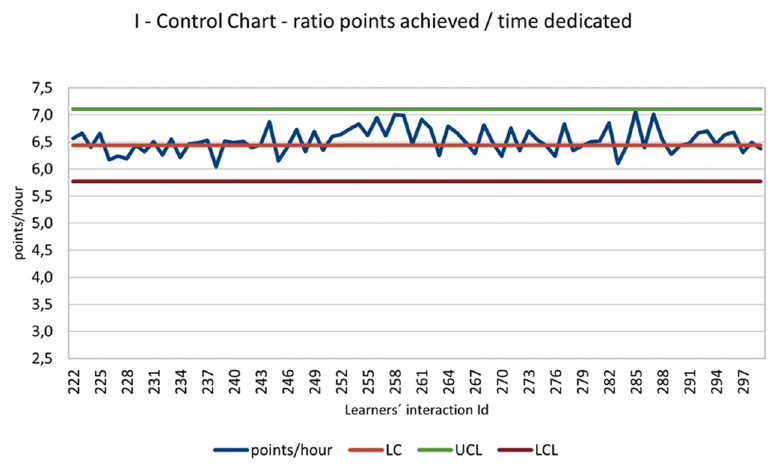
Figure 3. Ratio times and points for Learning Objects or